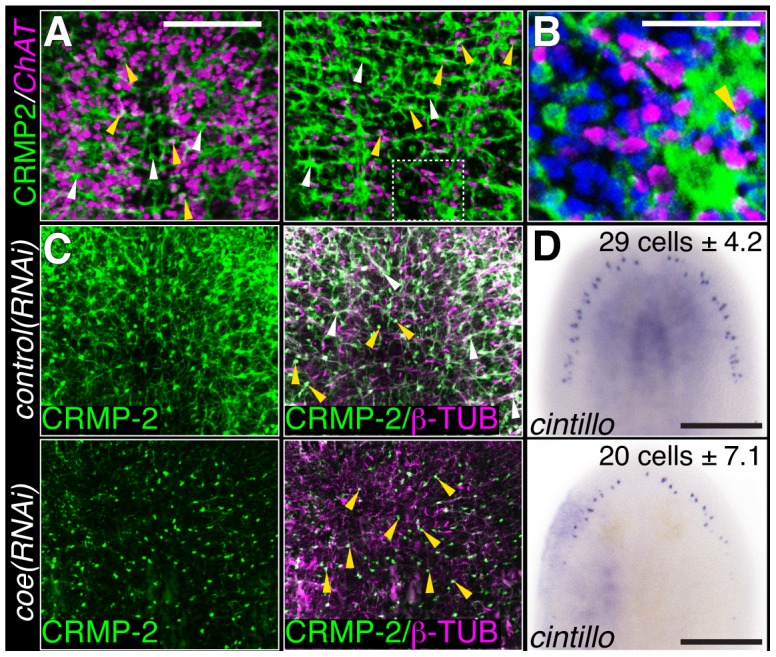
COE function is required for maintenance of nervous system architecture in uninjured planarians.(A) Head or tail images from an animal stained with anti-CRMP-2 and processed for FISH to ChAT. CRMP-2 is expressed in axon projections (white arrows) and neuronal cell bodies (yellow arrows; N = 7). (B) Higher magnification image of region denoted by white box in D shows CRMP-2 is detected in ChAT
+ cell bodies (arrowhead). Nuclei were stained with DAPI (blue). (C–D) Uninjured control and coe(RNAi) planarians labeled with anti-CRMP-2 and anti-β-TUBULIN or processed for in situ hybridization to cintillo. White and yellow arrows point to axon projections and cell bodies, respectively. N = 8 animals for each treatment; 412 and 290 cintillo+ cells were counted from control and coe(RNAi) animals, respectively. The number in the top right corner indicates the mean ± s.d. of cintillo+ cells; *P<0.05, Student's t-test. Anterior is up in all panels. Scale bars, A = 200 µm, D = 100 µm, E = 50 µm, and G = 200 µm.